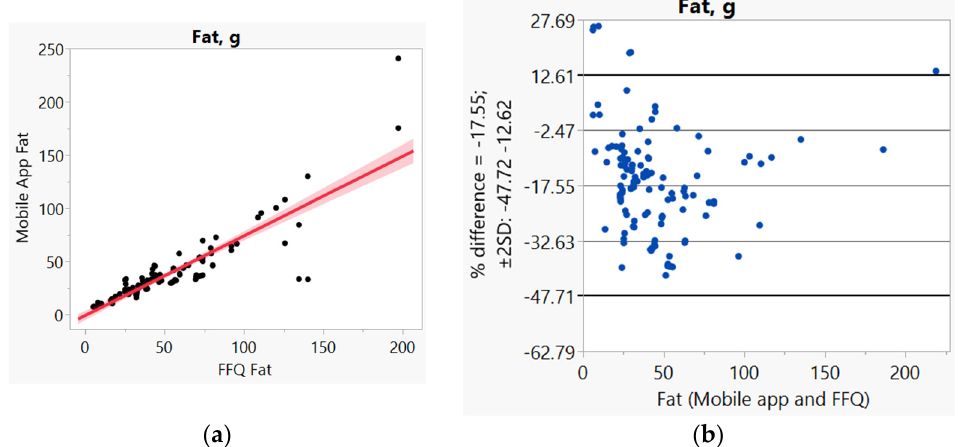
Figure 2. ( a ) Correlation, ( b ) Bland and Altman plots between mobile application and Food Frequency Questionnaire (FFQ) for fat.